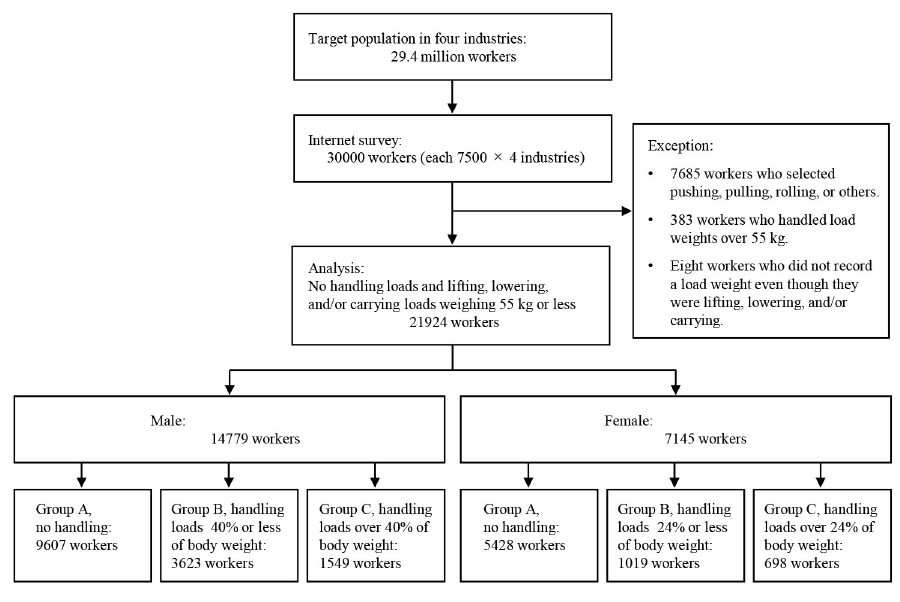
Fig 1. Flow chart showing participation in this